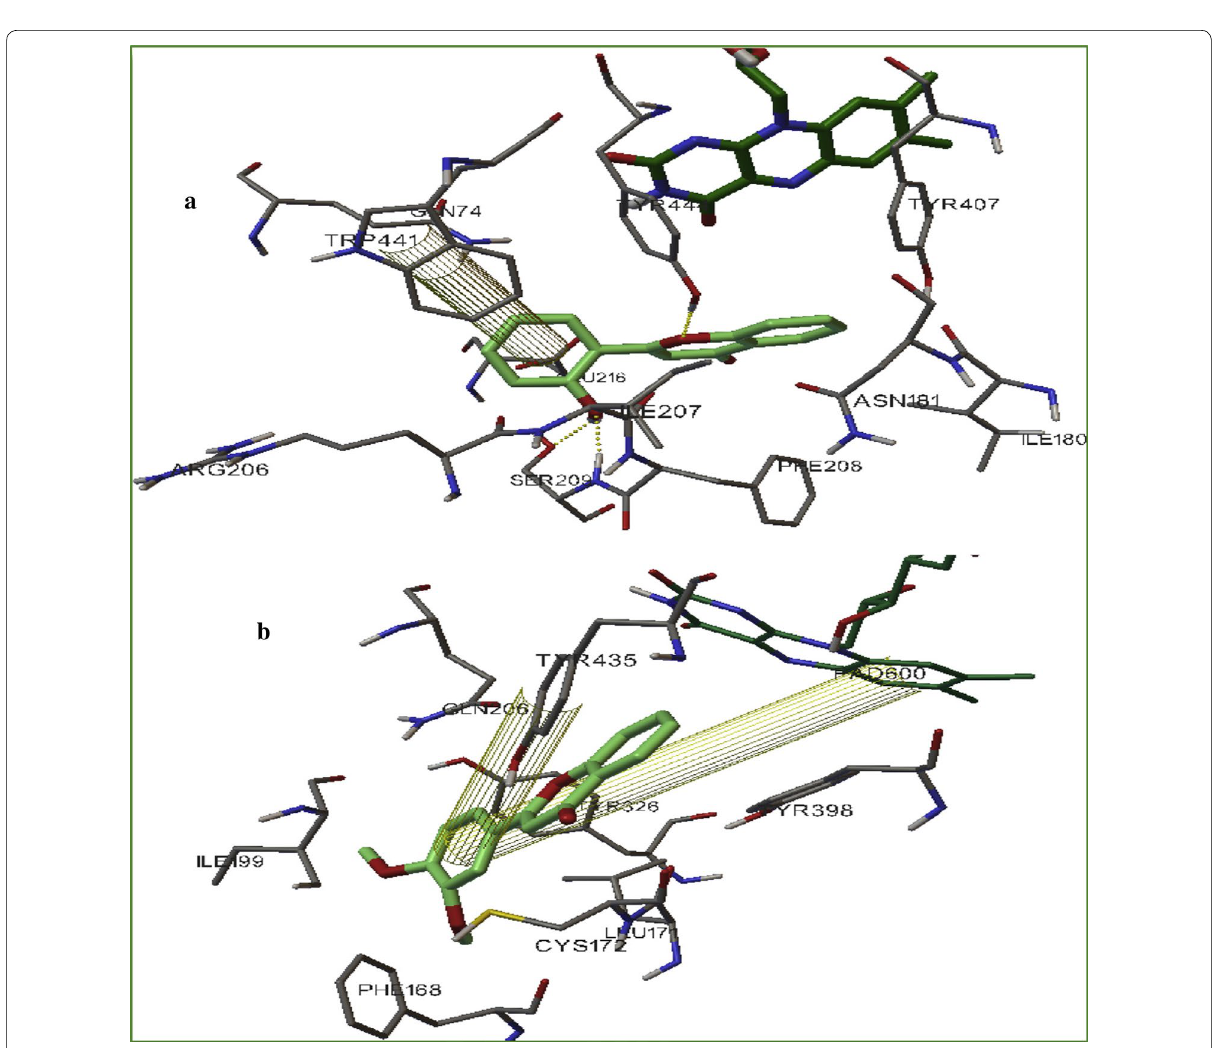
Fig. 62 a Interaction of compound C61 with human MAO-A. b Interaction of compound C60 with human MAO-B